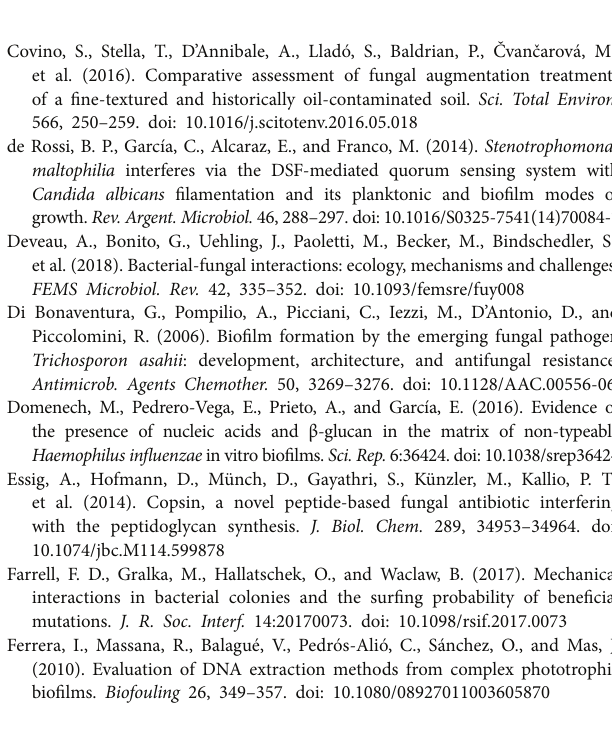
SUPPLEMENTARY FIGURE S1 | Volume rendering of P. alcaliphila and P. ostreatus 48-h-old mixed biofilm. Image A is the overlay of the SYTO 9 (B, live bacterial cells), PI (C, extracellular DNA and dead cells) and Calcofluor White D (D, hyphae) signals. ECM deposition (red fluorescence) is observed mainly in those areas where the hyphal network is more compact and highly interwoven (blue fluorescence). SUPPLEMENTARY FIGURE S2 | Standard curves obtained relating the log of each known concentration of gene copy number and the corresponding value of threshold cycle for mono-specific fungal (A) or bacterial (B) biofilms The values of slope and primers efficiency are shown to indicate the goodness of fit of the calibration curves. SUPPLEMENTARY FIGURE S3 | Linear regression curves between gene copy number and dry weight of biomass in monospecific biofilms. (A) 18S rRNA gene copy number vs Pleurotus ostreatus biomass. (B) 16S rRNA gene copy number vs. Pseudomonas alcaliphila